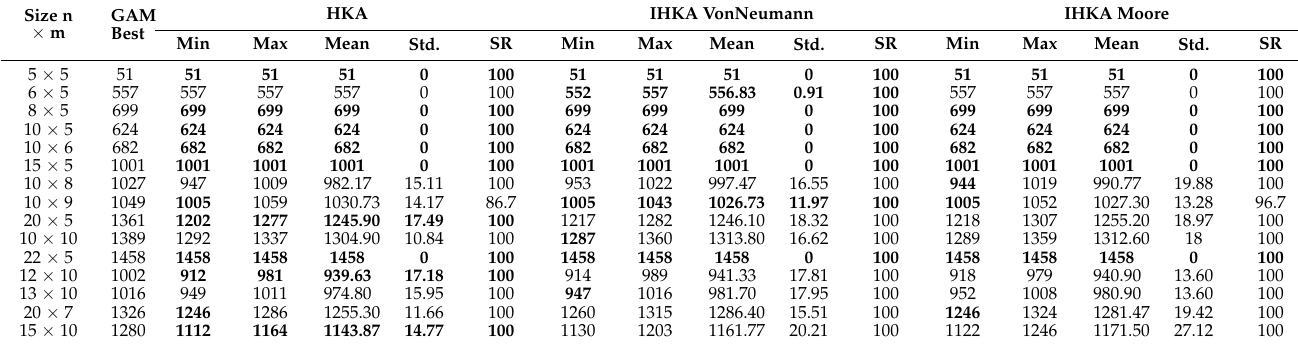
Table 4. The computational statistics of the IHKA and HKA on the fitness for the benchmark instances of DJSSP. Size n × m